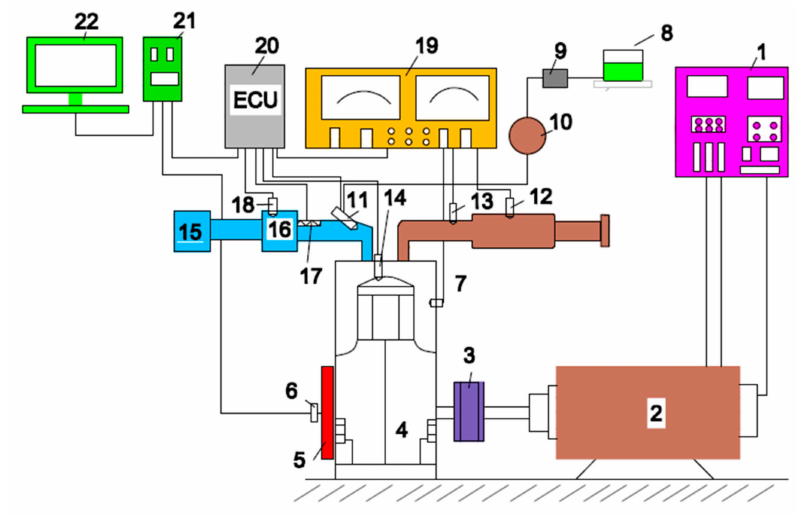
Figure 1. Schematic of the engine experimental setup [13].